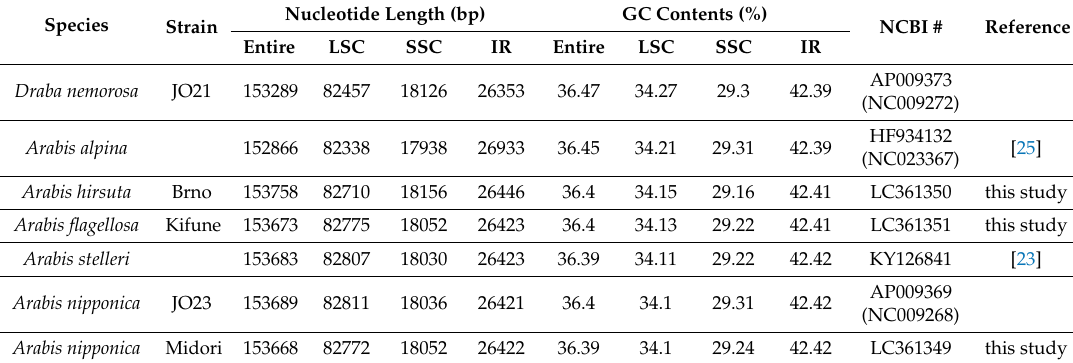
Table 1. Summary of chloroplast genome structure in Arabis